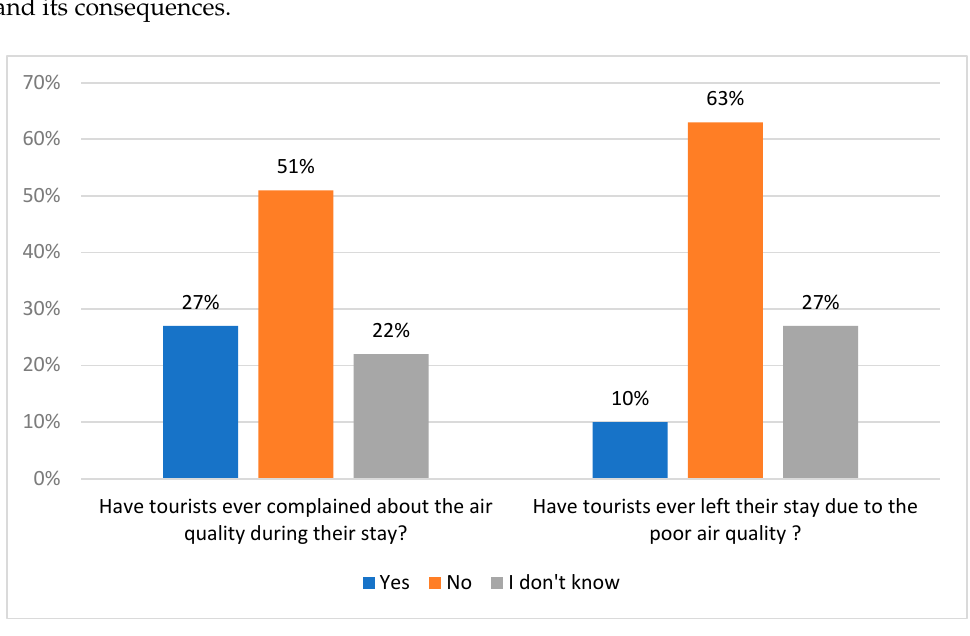
Figure 13. Tourists’ sensitivities to air quality in visited places. Source: own study.